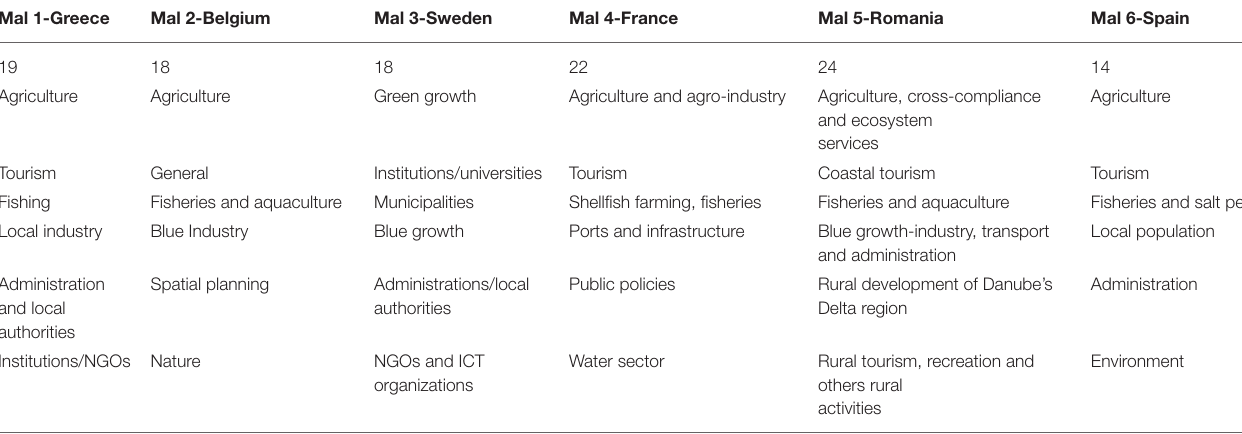
TABLE 2 | Participants multi-actor labs and what sectors they represented in each